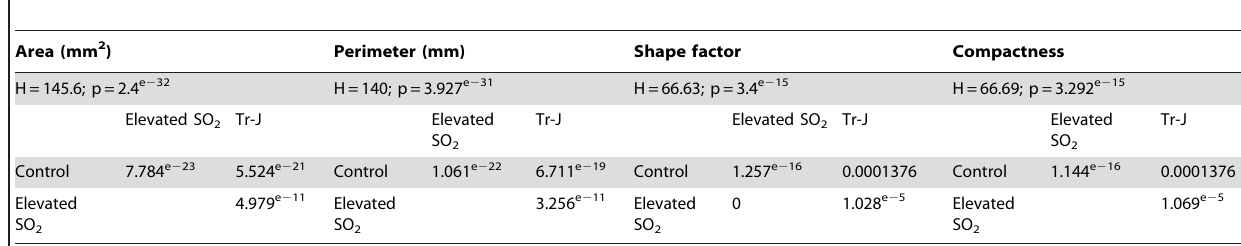
Table 1. Kruskal Wallis and Mann-Whitney pair-wise comparisons for each physiognomic trait in Lepidozamia peroffskyana in the different simulated palaeoatmospheric treatments.